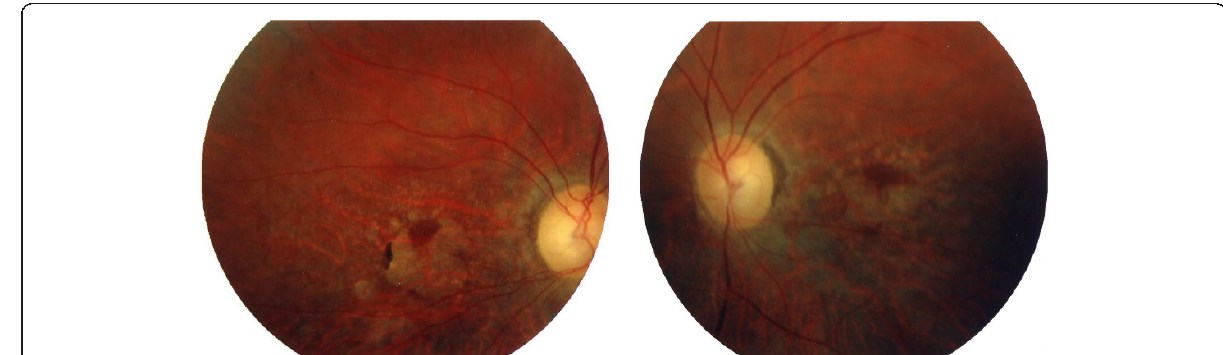
Figure 2 Fundus photographs of the patient III:1 . at 47 years of age showing area of macular atrophy, rare pigment deposits and attenuation of retinal